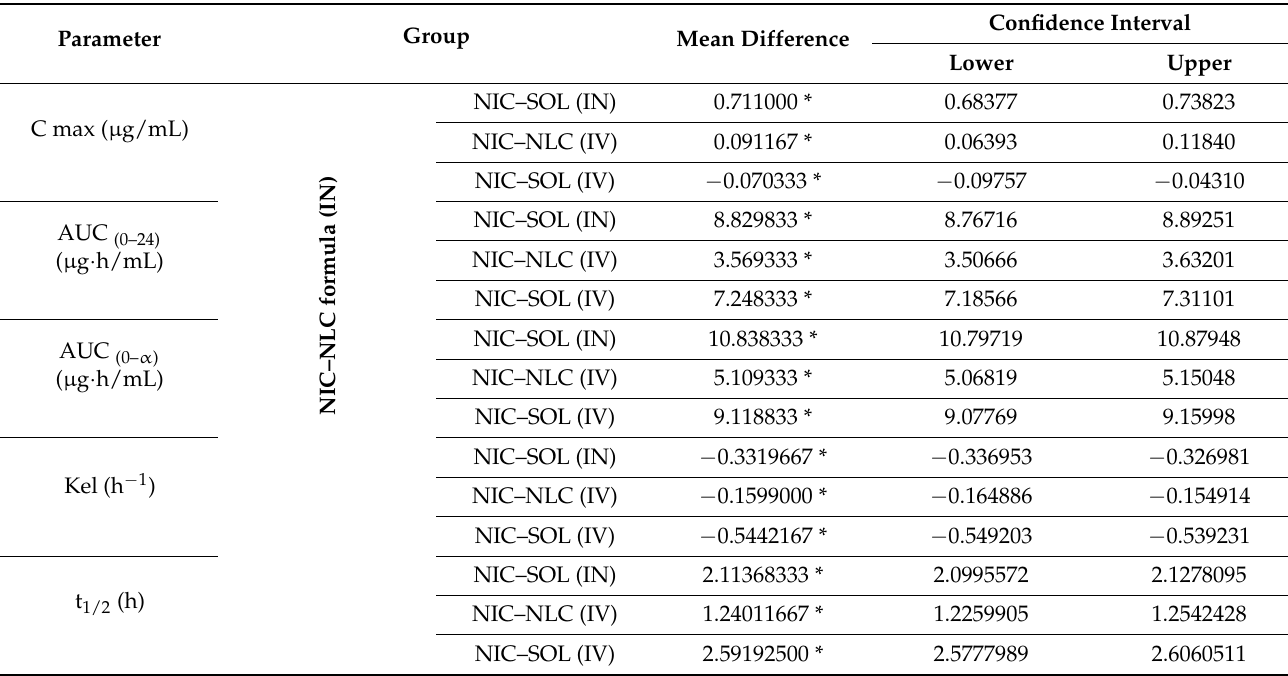
Table 10. Post hoc statistical analysis of the calculated mean differences of different pharmacokinetic parameters in brain. Parameter